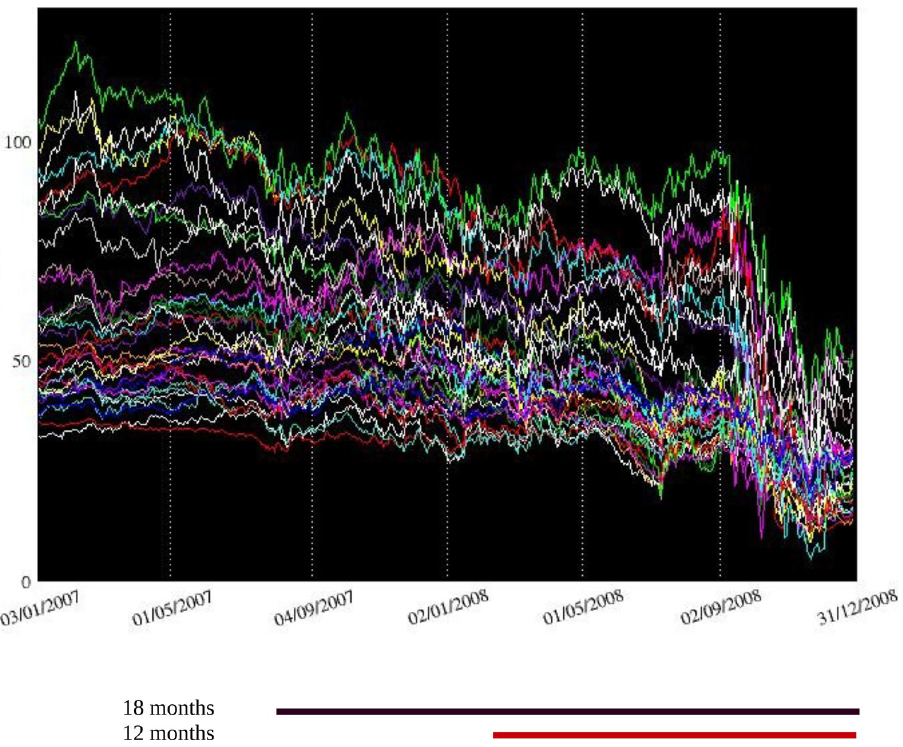
Figure 3. Stock market prices of financial institutions between 1/3/2007 and 12/31/2008. The figure presents the evolution of daily stock market prices of the 47 US banks included in our sample. The straight lines at the bottom of the figure correspond to the alternative time periods we use—July 2007 to December 2008 and January 2008 to December 2008—to define the